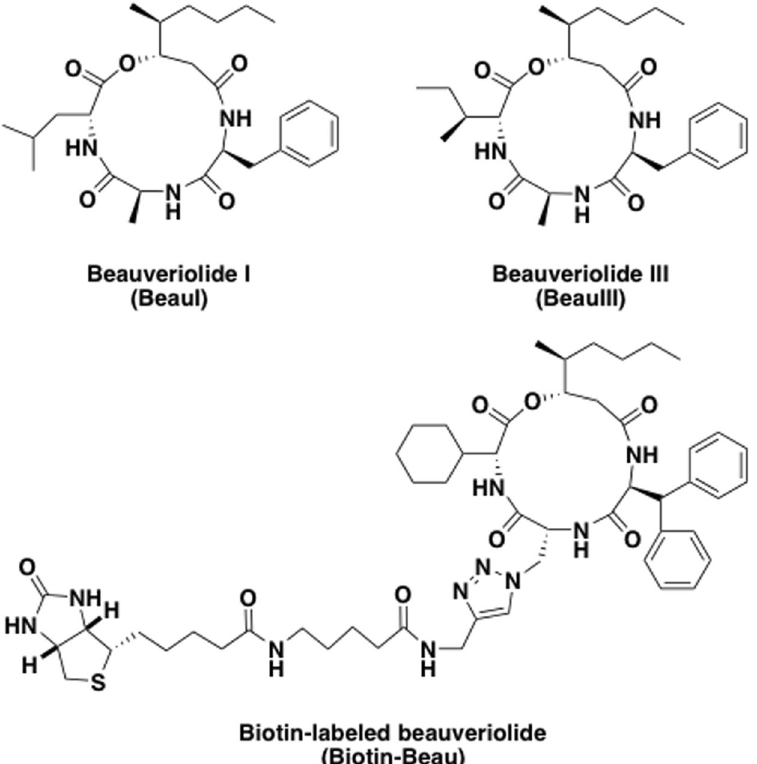
Figure 1. Structures of beauveriolides and biotin-labeled